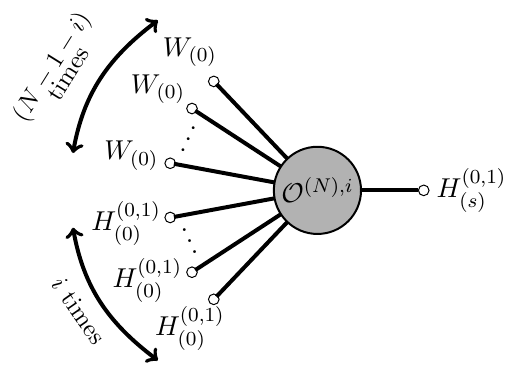
as ( N (cid:0) 1 (cid:0) i ) W ( s )